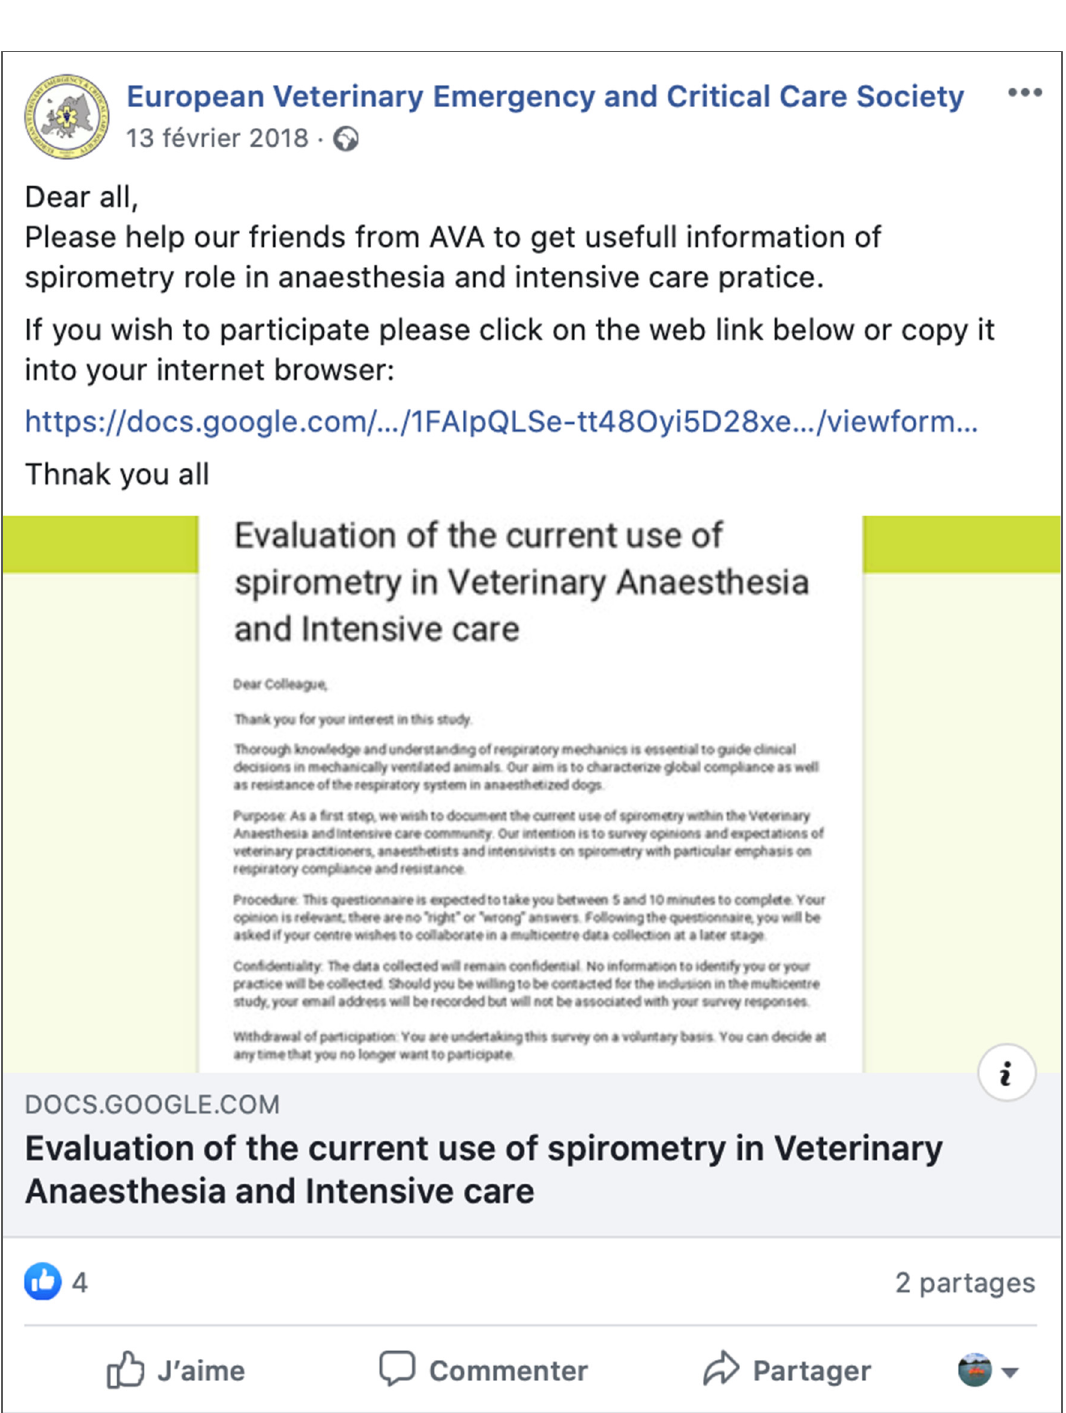
Figure A5. Example of survey announcement on the Facebook page of the European Veterinary Emergency and Critical Care Society.